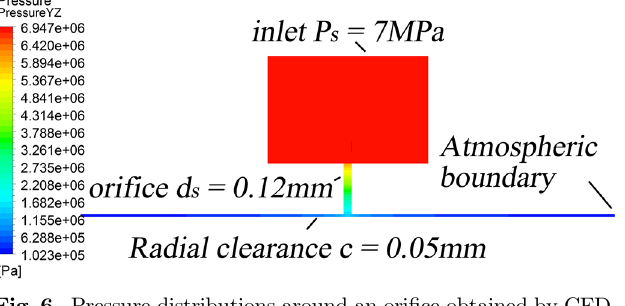
Fig. 6. Pressure distributions around an ori fi ce obtained by CFD.